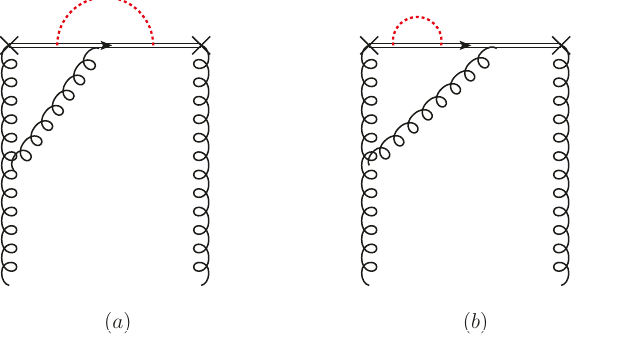
Figure 10 . Typical two-loops corrections to quasi gluon distribution, in which both the endpoints of the added gluon line are connected to the Wilson